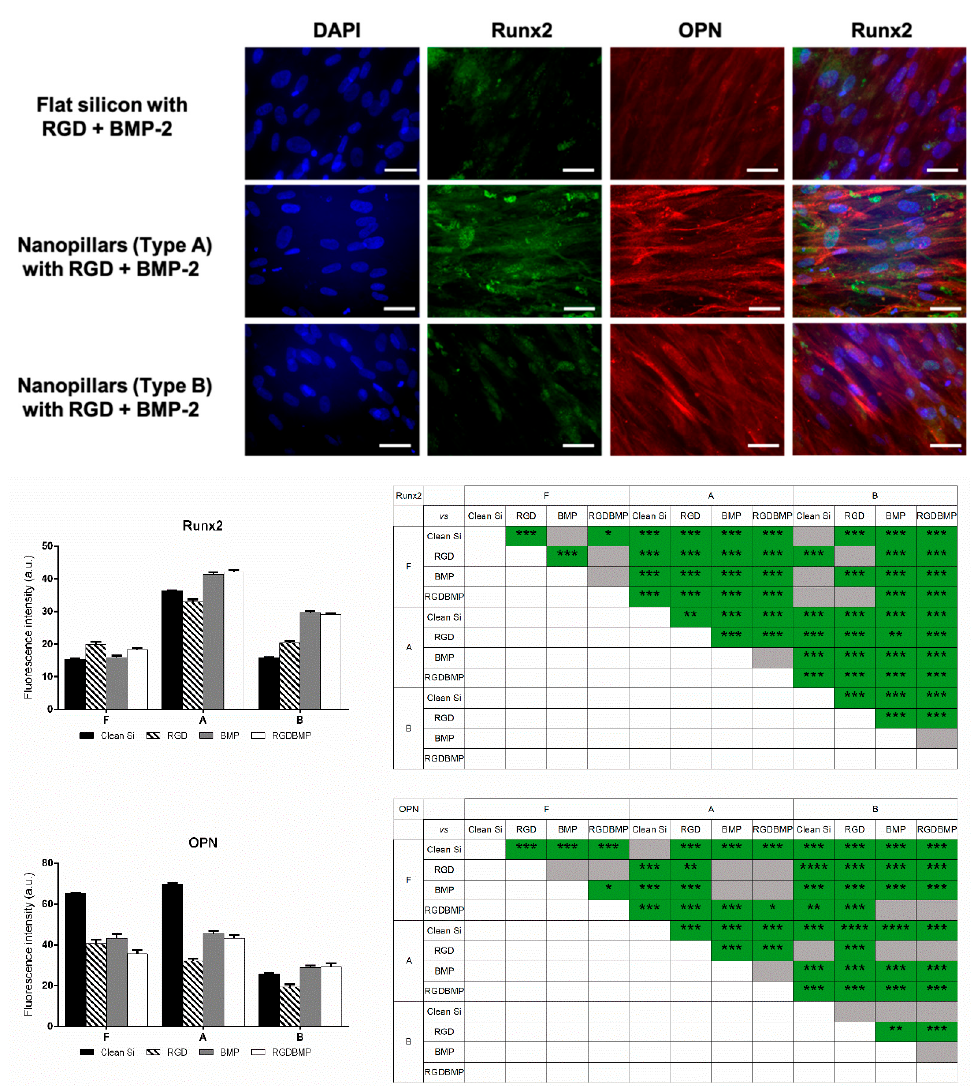
Figure 4. hMSCs cultured for 2 weeks on flat silicon (F) and silicon with Nanopillars A and B (Table 2) before and after functionalization with RGD and/or BMP-2 peptides (RGD alone, BMP-2 alone or combined RGD/BMP-2 peptides). Cells were stained for the early osteogenic (Runx2) marker in green, the late osteogenic (OPN) marker in red and cell nucleus in blue. An example is given here with RGD + BMP-2 peptides immobilization ( above ) (scale bar: 40 µ m). Quantitative analyses of the nuclei immunofluorescence intensity of Runx2 and OPN in hMSCs ( left ). Tables ( right ) summarize significant differences between conditions (grey: non-significant, green: significant differences. * represents p < 0.05, ** p < 0.01, *** p < 0.001).